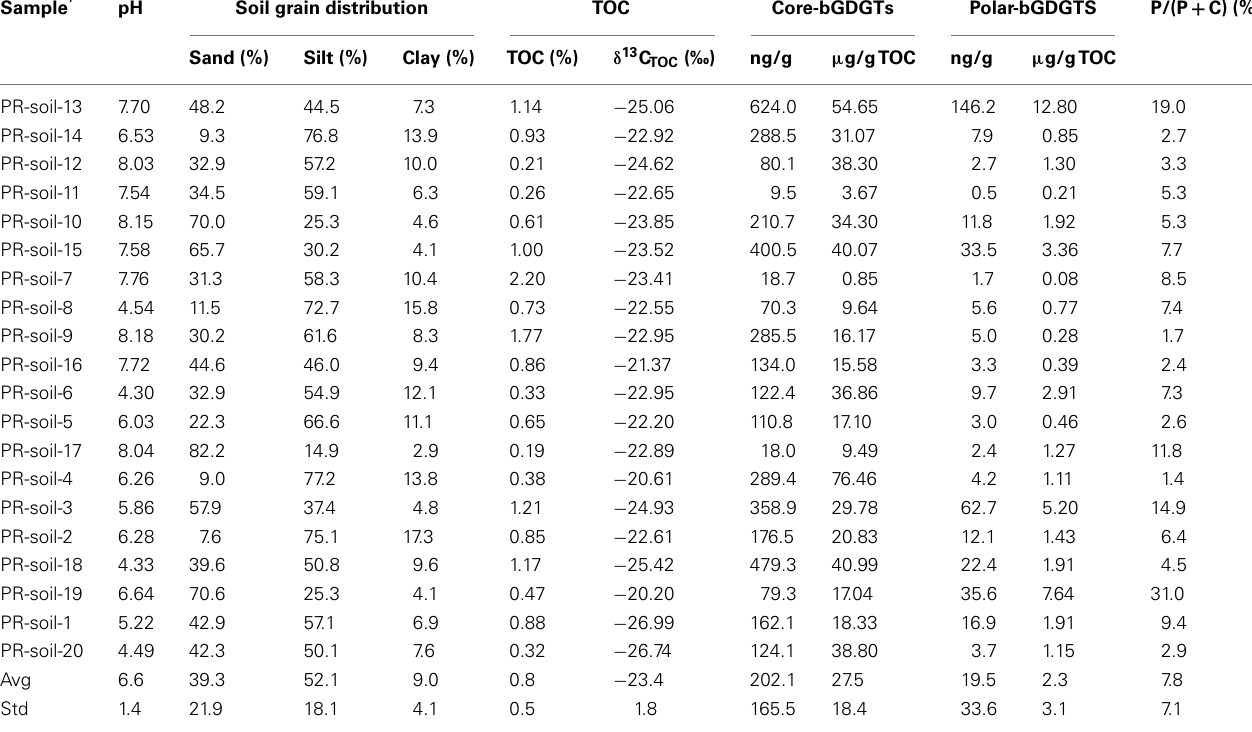
Table 3 | Basic information on pH, grain size distribution, total organic carbon (TOC) and carbon isotope compositions, and lipids of surface soils in the lower Pearl River drainage